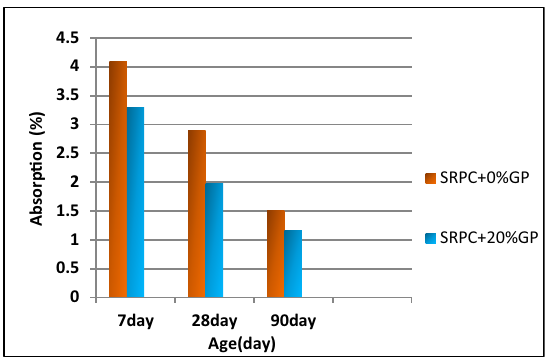
Figure 8: Relationship between the absorption ( % ) and age ( day ) for